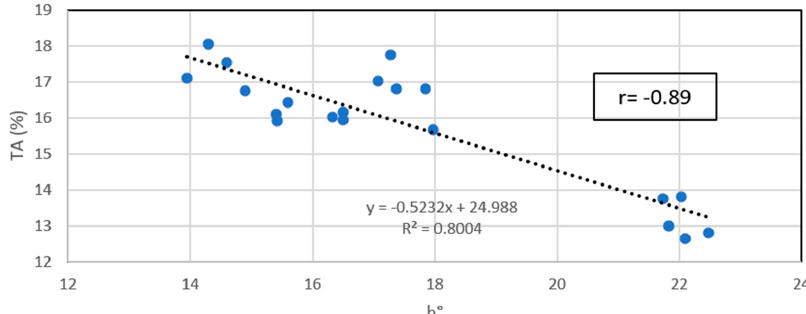
Figure 10. Correlation between total soluble solids (TSS) of ‘Regina’ sweet cherry fruit and h° in 2009–2012 regardless of treatment.